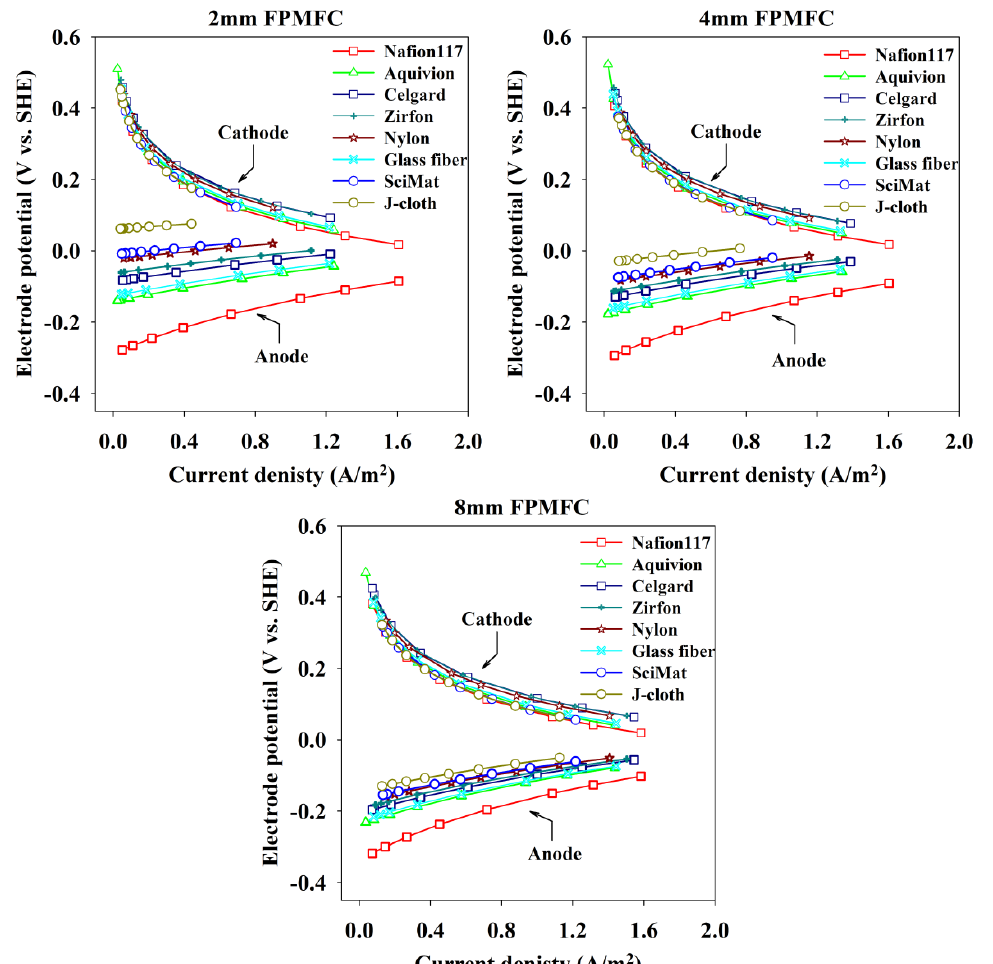
Figure 2. Estimated electrode potentials using different separators in the FPMFCs.